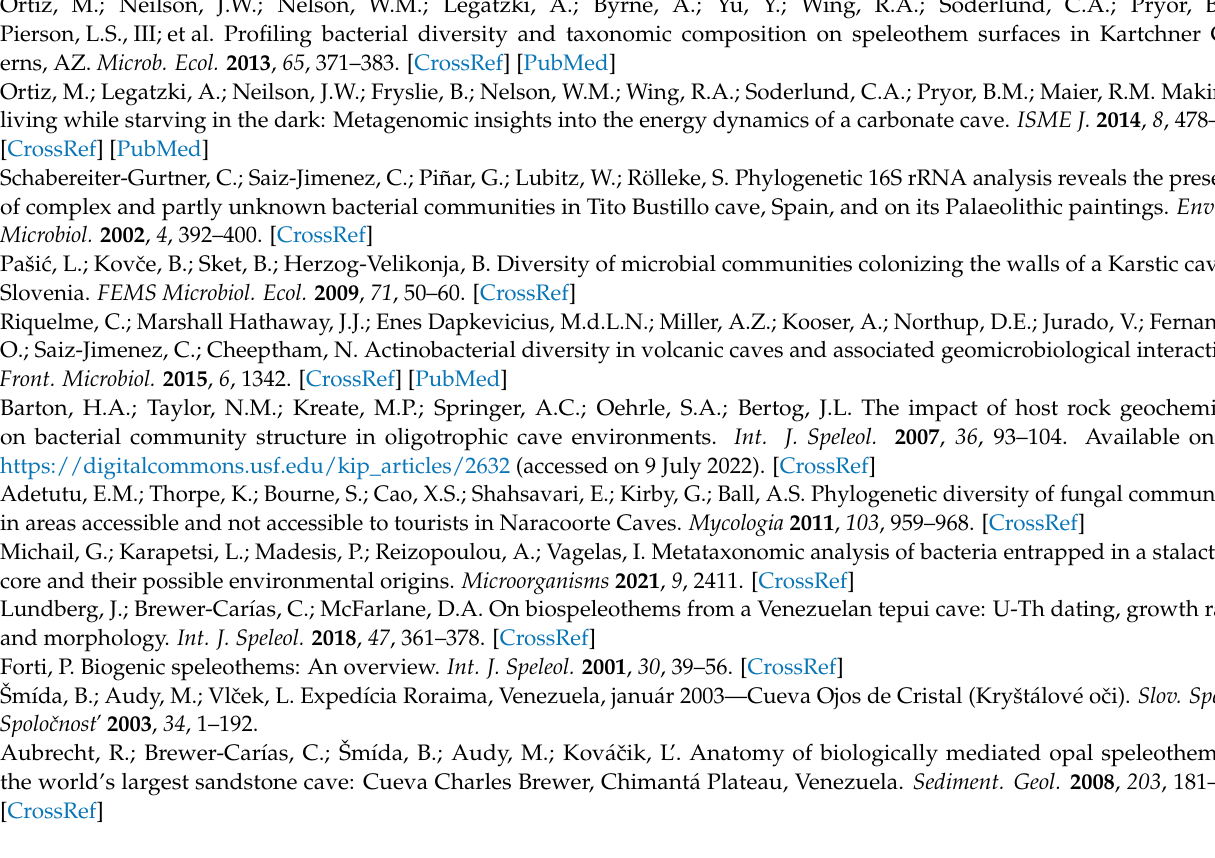
Table S1: Taxonomic biomarkers having LDA scores >4 and their corresponding codes in Figure 9 and Figure